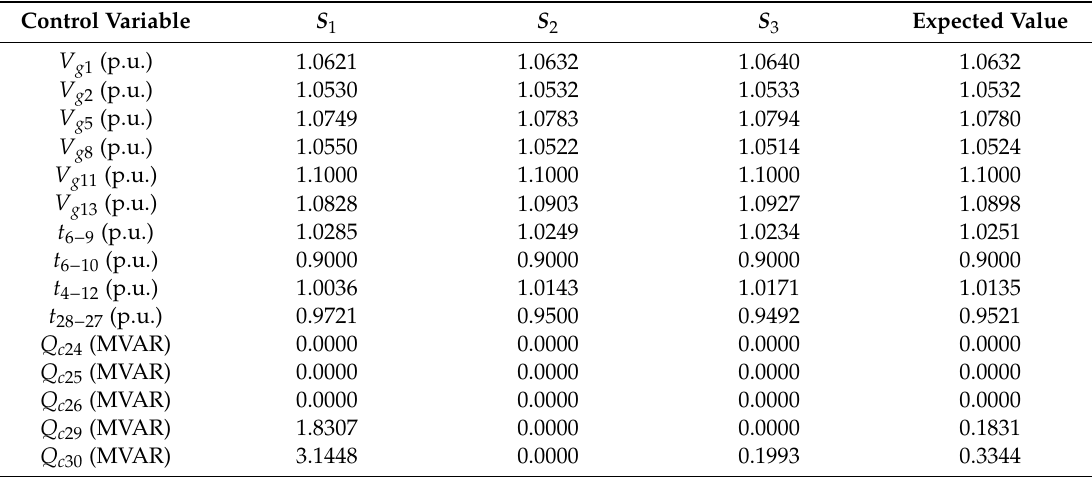
Table 11. The optimal values of the control variables among the load scenarios for probabilistic multi-objective RPP considering the load demand uncertainty.